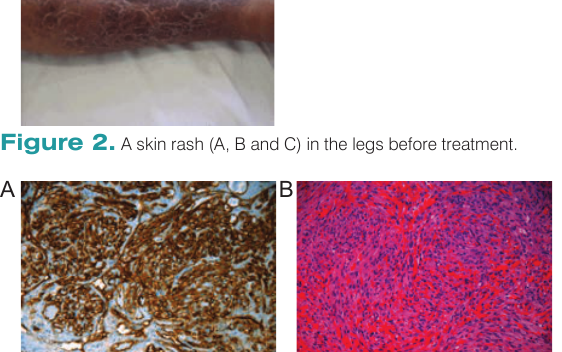
Figure 1. (A) Immunohistochemistry stain showing lymphoid cells positive for BCL-2 (magnification 400x), (B) lymphoid cells positive for CD20 (magnification 400x), (C) Hematoxylin- eosin (HE) stain showing lymphoma cells (magnification 200x).